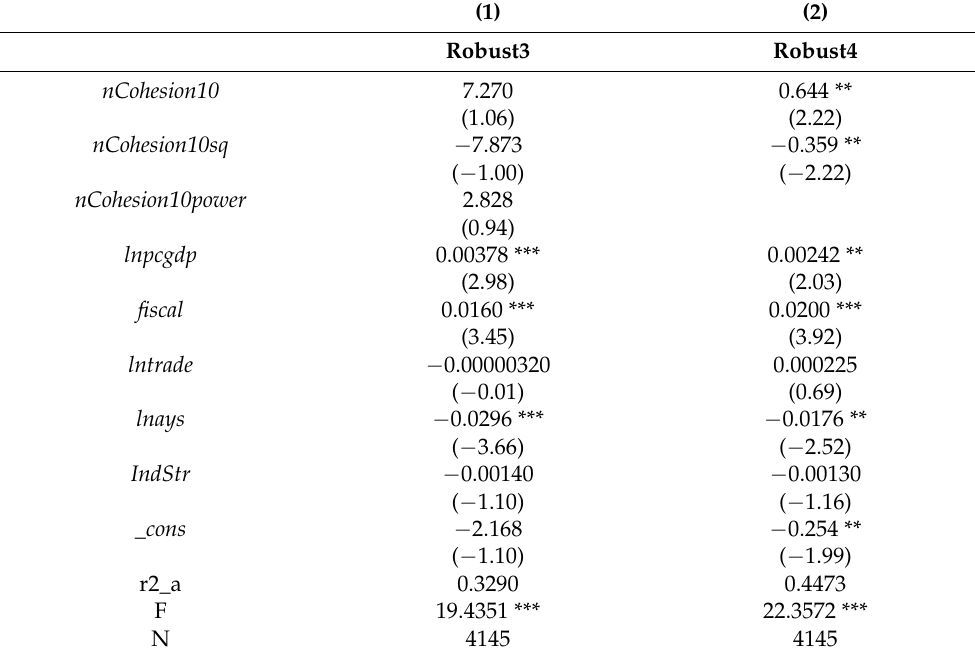
Table 9. Robustness tests: other